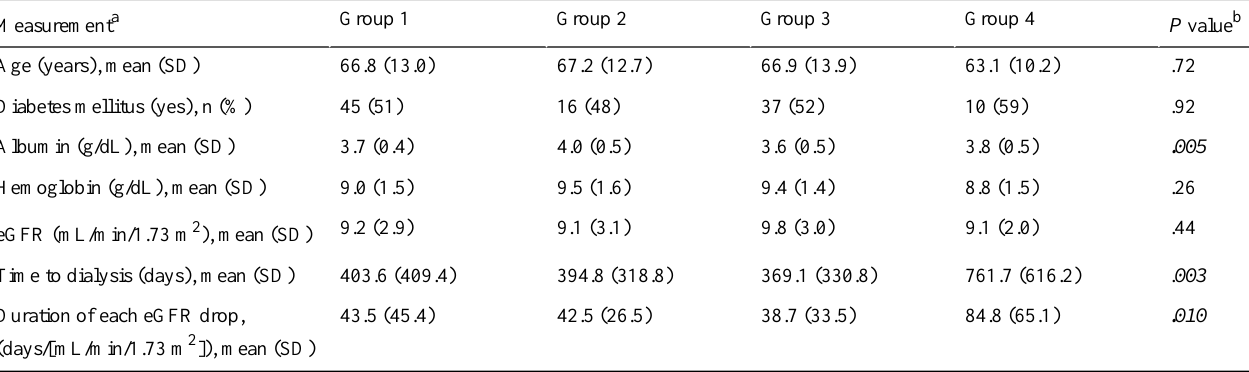
Table 3. Comparison of clinical and laboratory measurements by group, adjusted for baseline estimated glomerular filtration rate